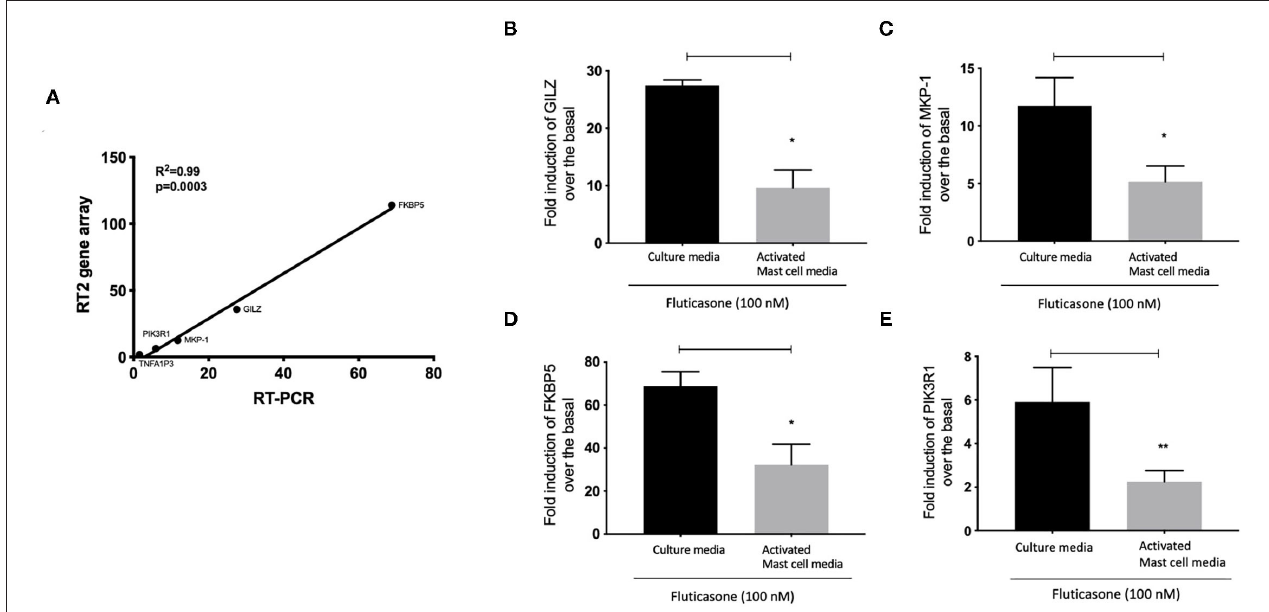
FIGURE 7 | Individual real time PCR analysis confirmed the inhibition of fluticasone-induced gene expression by activated mast cell conditioned media. Healthy ASM cells were pre-treated with control mast cell media, conditioned media from 24-h non-activated, or 24-h activated mast cells for 24h before cells were washed and stimulated with or without 100nM fluticasone for an additional 6h. Expression of anti-inflammatory genes of GILZ (A) , MKP-1 (B) , FKBP5 (C) , and PIK3R1 (D) was assessed by real-time PCR. Data were normalized to the housekeeping gene (GAPDH) and presented as fold change over the basal condition using the 2 − 11 ct method as Means ± SEM, n = 7 different cell lines (* p < 0.05, ** p < 0.01). (E) Validation of the gene array data using individual PCR. The log2 fold induction of the 5 genes shows a strong correlation with the results found using Qiagen RT2 profiling gene array and qRT-PCR, (R 2 = 0.99, P =